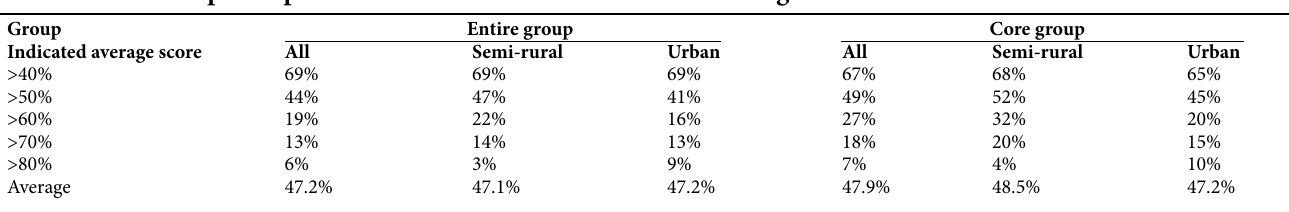
table II. ratio of participants with scores above the indicated average scores group Entire